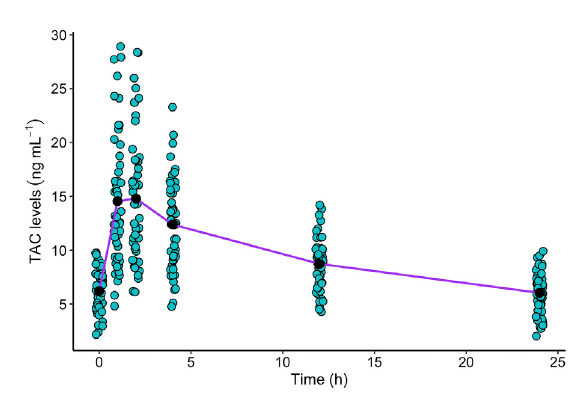
FIGURE 1 Plasmatic TAC levels in 24 h monitoring, were obtained in children and adolescentkidney recipients(n = 51)atC 0 ,C 1 , C 2 ,C 4 , C 12 and C 24 timepoints. We represented with dots each TAC level to be able to visualize the dispersion of the data. The black dots representthemeanTACconcentrationateachtime-point.Thepurple line represents the mean TAC concentration-time